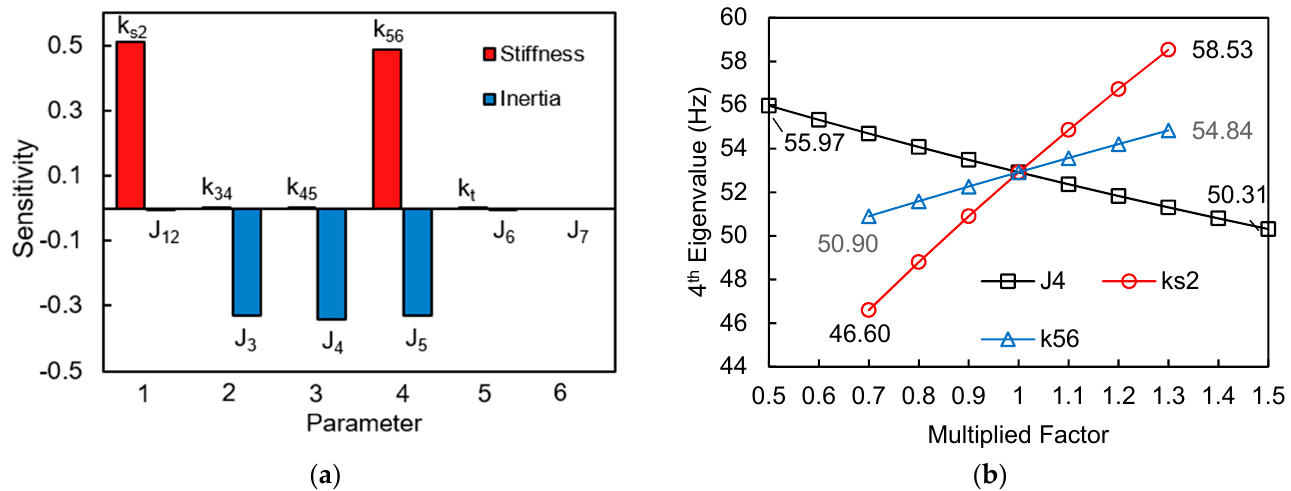
Figure 9. Results of sensitivity analysis. ( a ) Sensitivities of the 4 th natural frequency; ( b ) influence of sensitive parameters on the 4 th natural frequency.